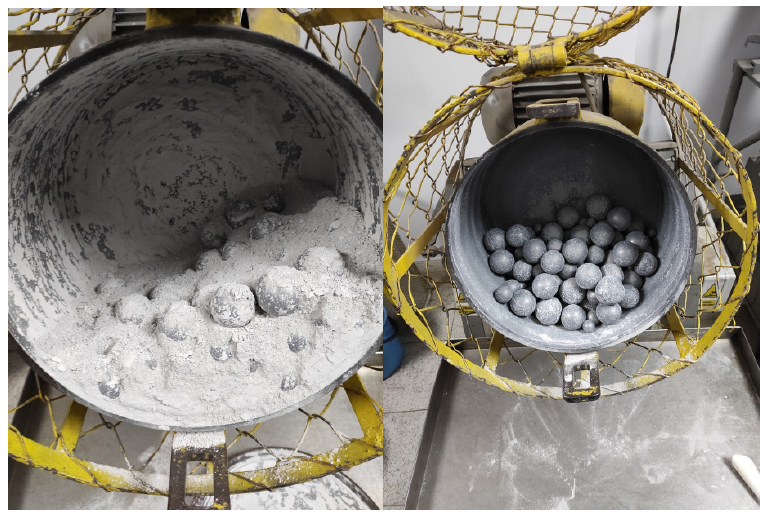
Figure 1. Ball mill-laboratory scale.